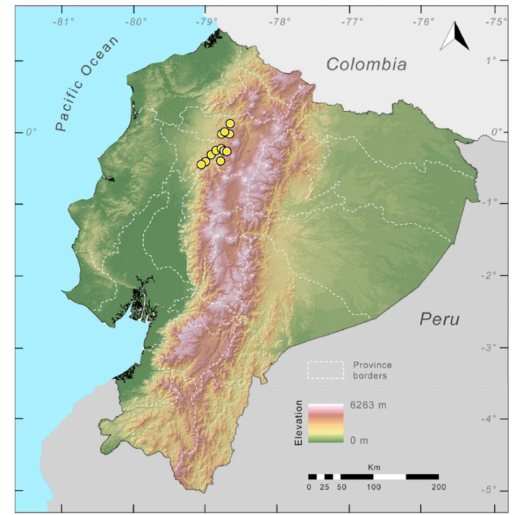
Figure 157. Distribution of Nymphargus gri ffi thsi in Ecuador (yellow